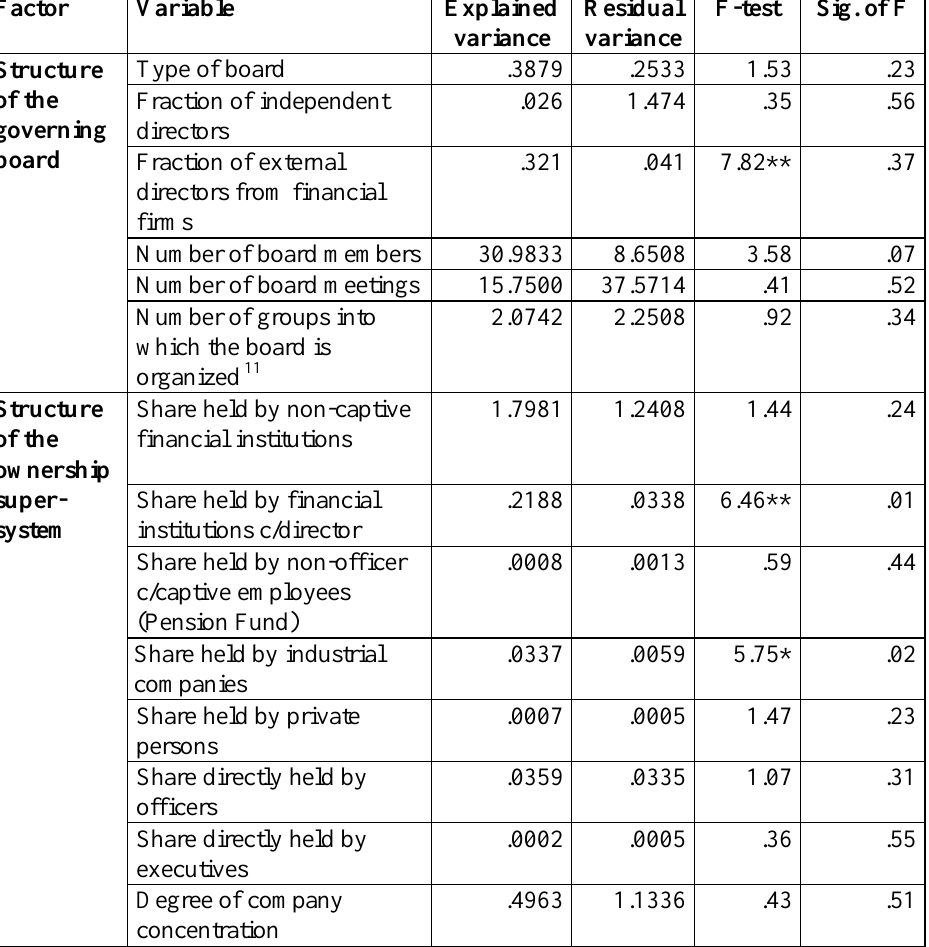
Table 4: Variance